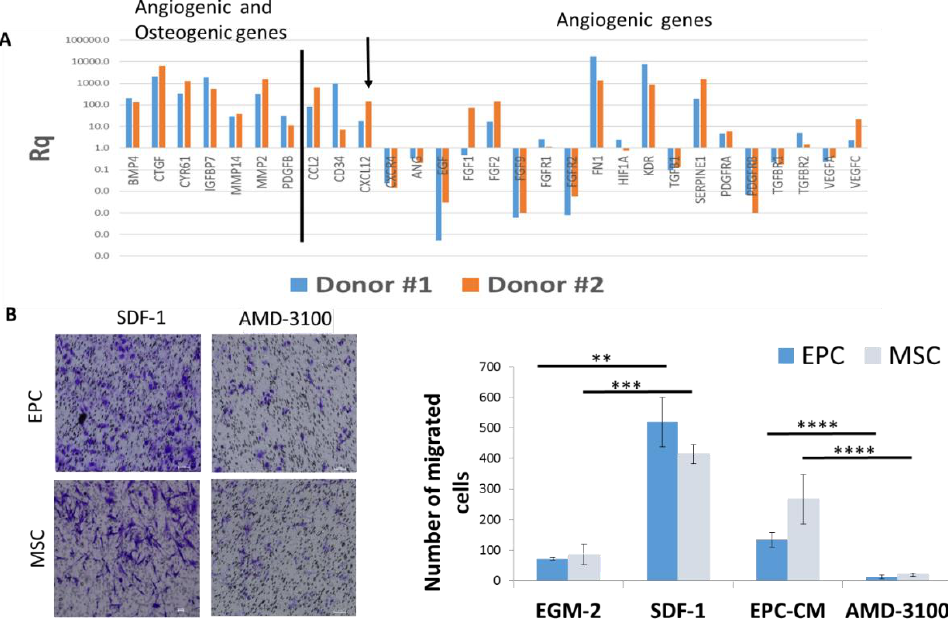
Figure 5. SDF-1 in EPC-CM plays a key role in EPC and MSC migration. ( A ) Relative quantification values of mRNA expression of osteogenic and angiogenic genes showed high expression of CXCL12 (arrow). Results were normalized relative to housekeeping gene and MNCs from the same donors. RQ values obtained for all genes were added to Supplementary File (Figure S1). ( B ) Migration of EPCs and MSCs towards SDF-1 was evaluated in a transwell migration assay. Migration was blocked by the addition of AMD3100 to the cells. ** p < 0.01, *** p < 0.001, **** p < 0.0001. Scale = 100μm.